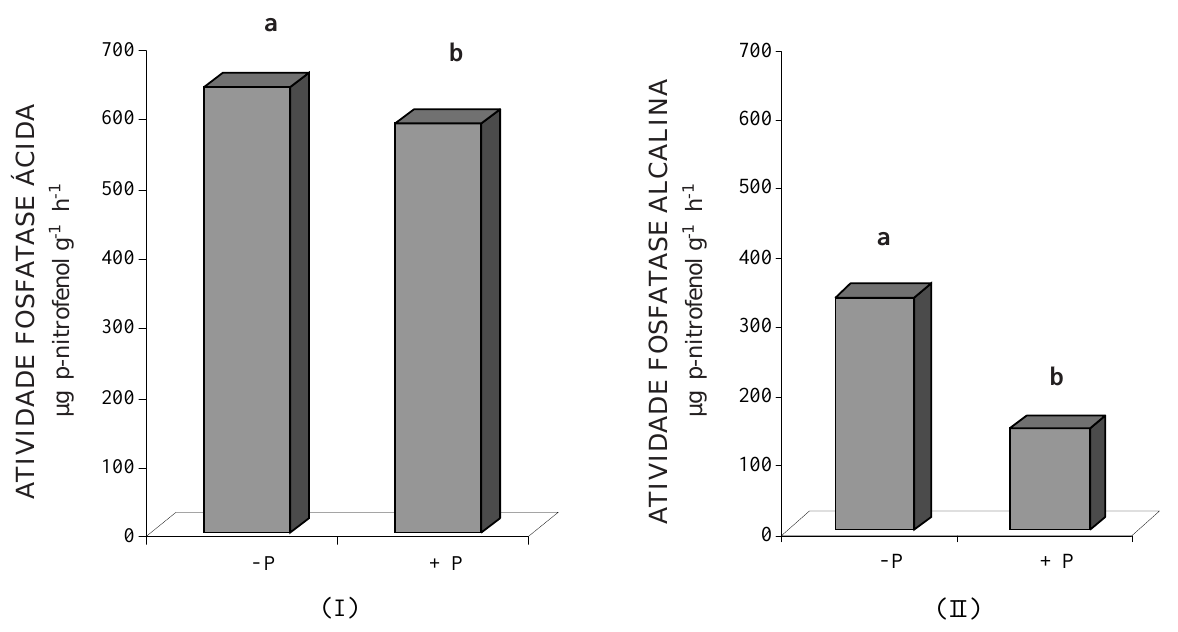
Figura 4. Efeito da adição de 124 mg de fósforo inorgânico por mL da mistura de reação sobre a atividade de fosfatases ácidas (I) e alcalinas (II). Em cada gráfico as barras com mesma letra diferem entre si pelo teste de Tukey a 5% de